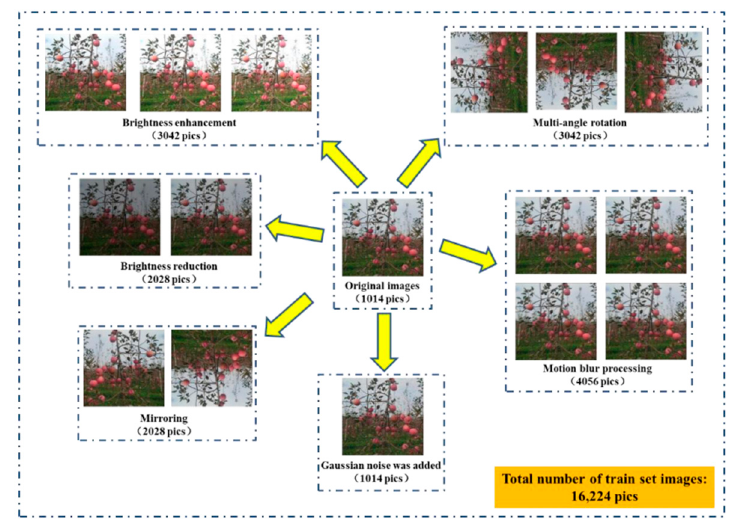
Figure 2. Data augmentation process.